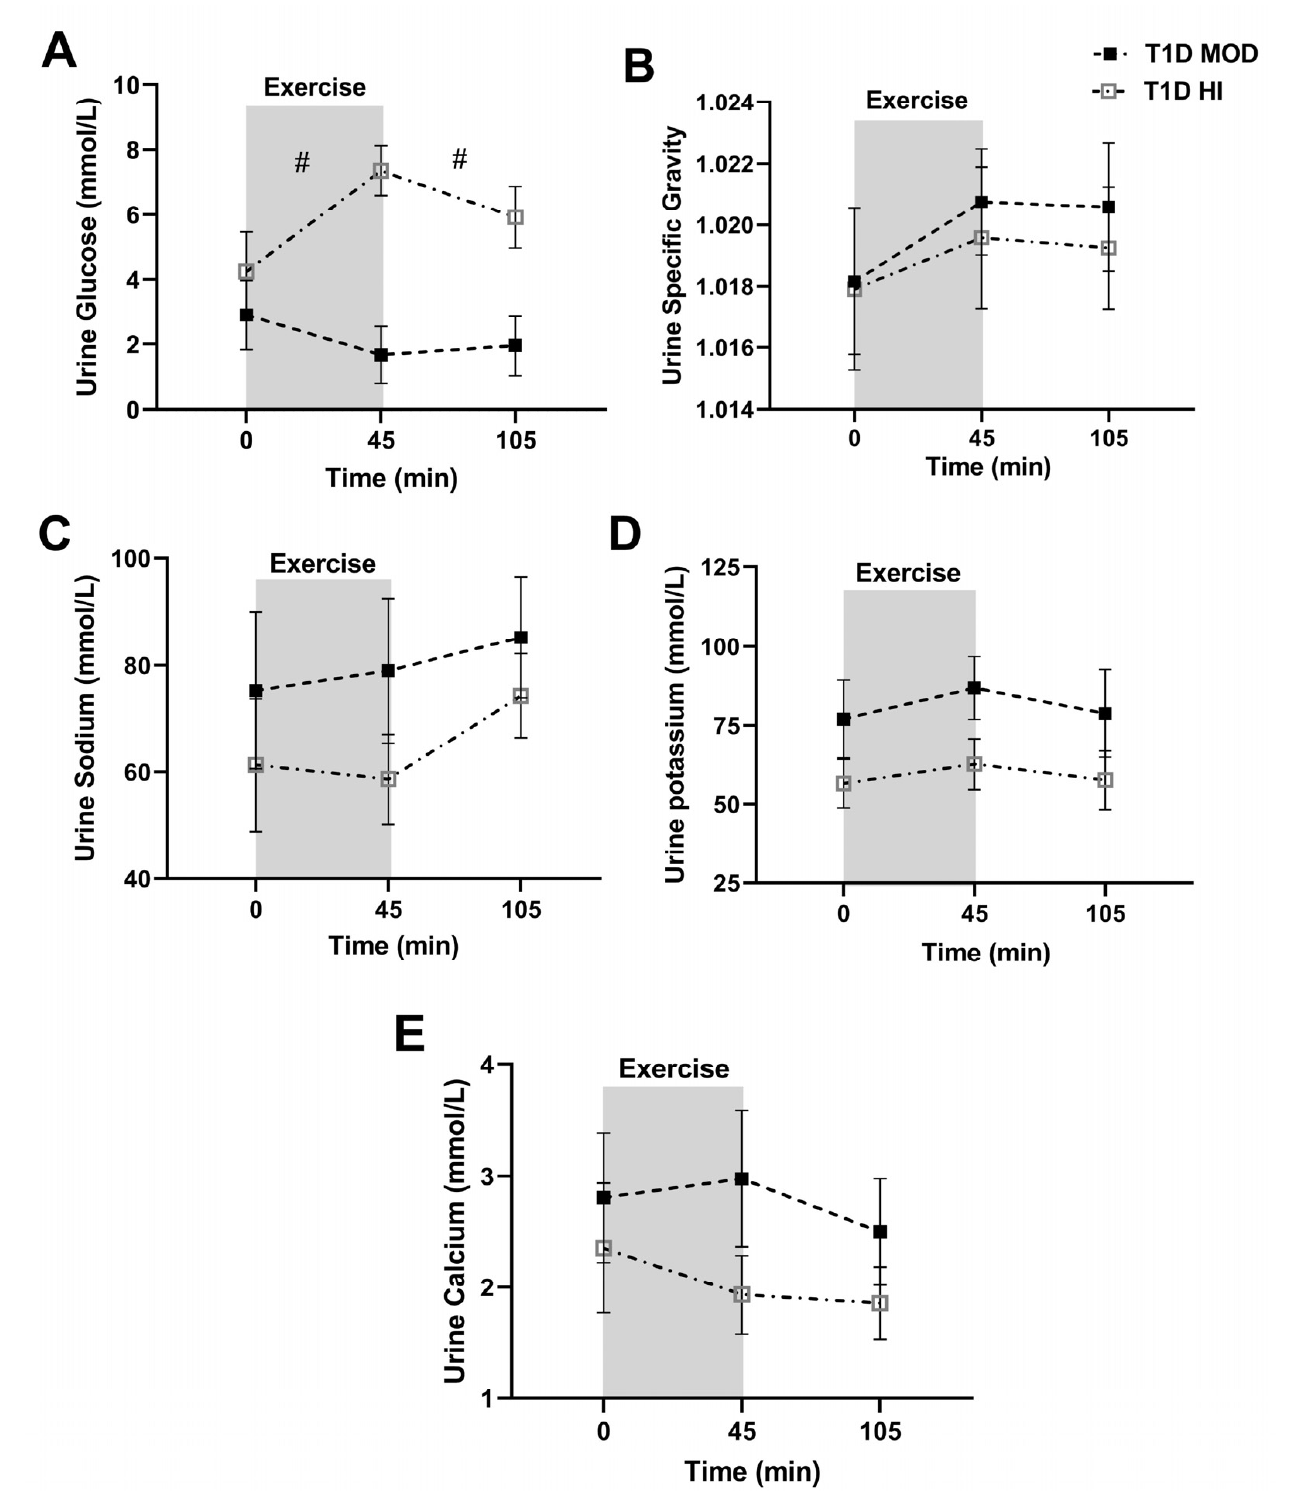
Figure 2. Urine concentration (mean ± SEM) of glucose ( A ), urine specific gravity ( B ), and urine concentrations of sodium ( C ), potassium ( D ), and calcium ( E ) before exercise (time 0), at the end of exercise (45 min), and at the end of the 60-min recovery (105 min) in T1D MOD (black squares) and T1D HI (grey squares). # shows significant differences (treatment effect) between MOD and HI from the beginning to the end of exercise and from the end of exercise to the end of recovery compared by